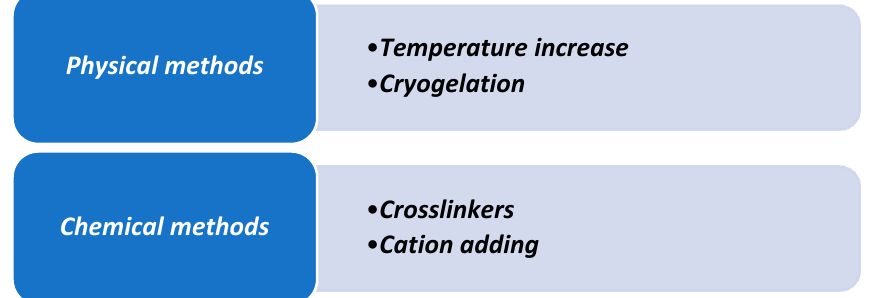
Figure 2. Gelation agents in natural hydrogels.